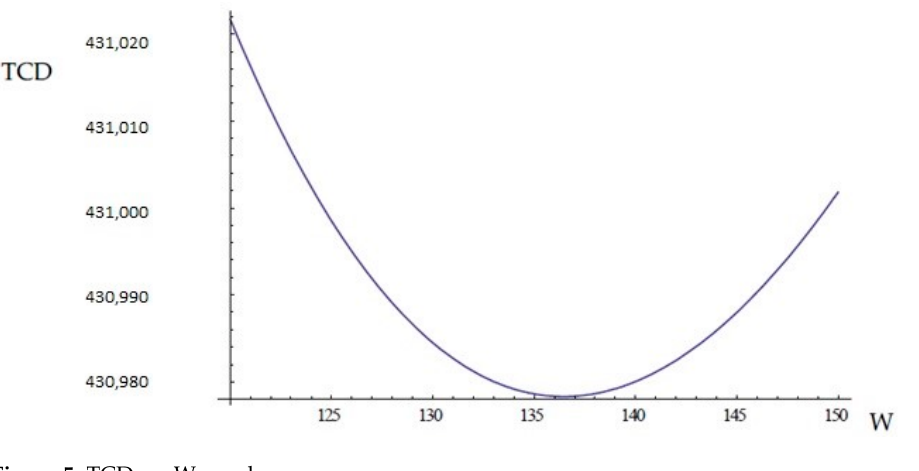
Figure 4. Convexity of TCD with respect to W and Q s .